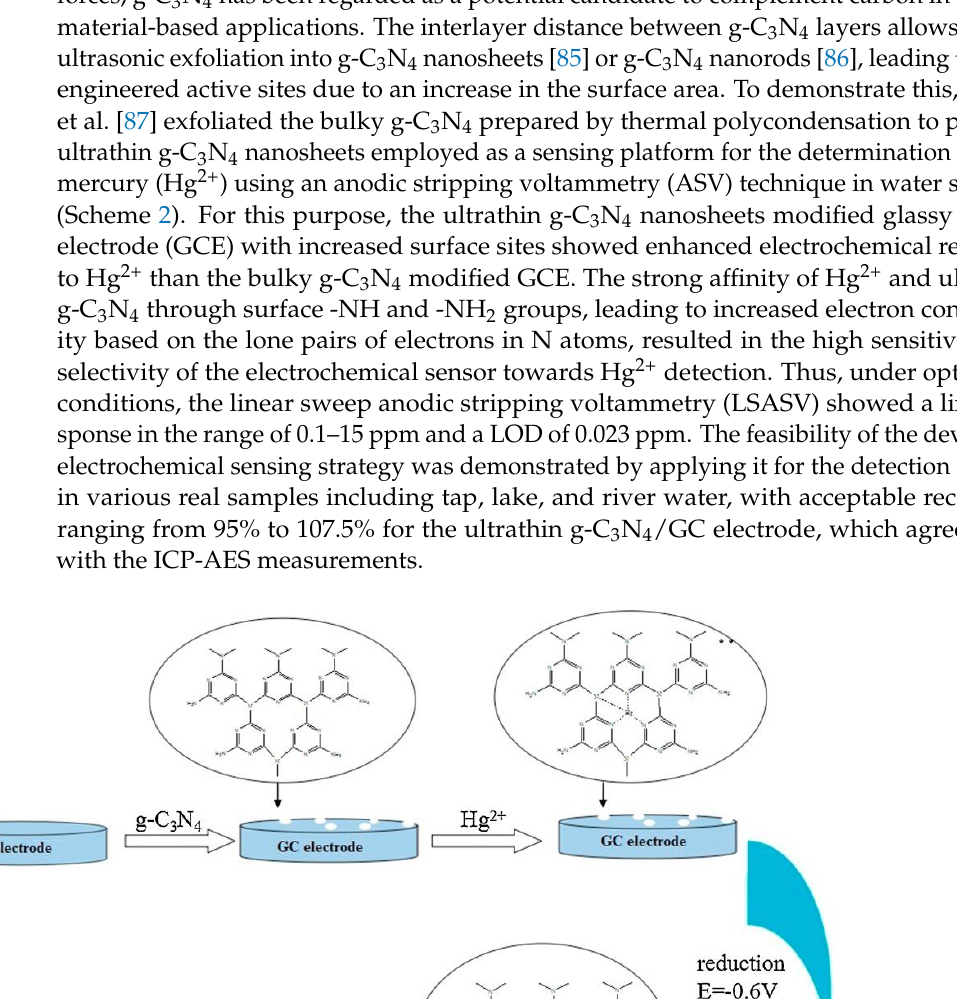
8 of 28 Figure 2. FE-SEM images of ( a ) graphene oxide (GO), ( b ) reduced graphene oxide (rGO), ( c ) α-MnO 2 , ( d ) α-MnO 2 /rGO nanocomposite (reproduced with permission from [81]; copyright 2019, Taylor & Francis Group). 5.1.2. Graphitic Carbon Nitride-Based Nanocomposites